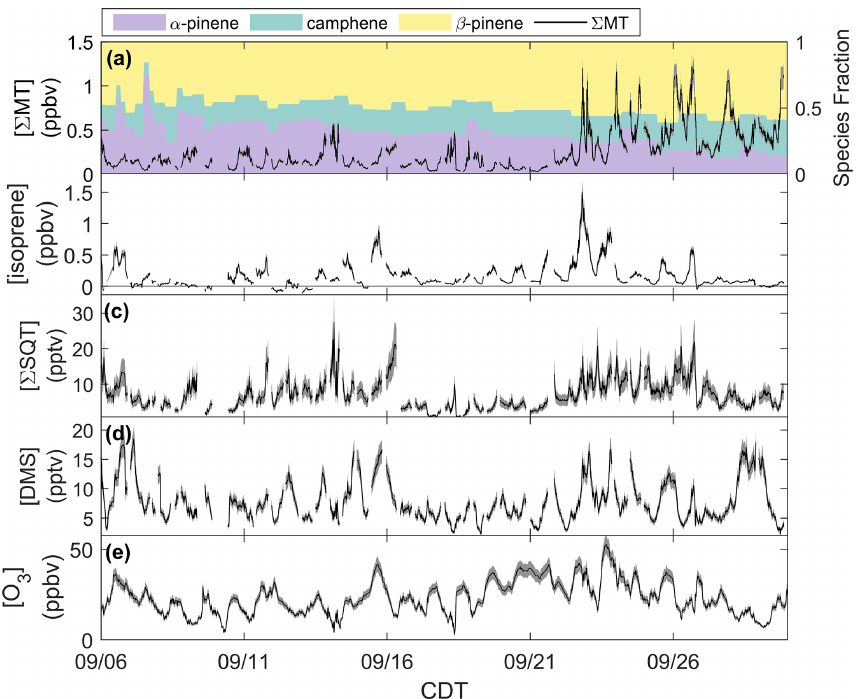
Figure 2. Mixing ratios of (a) (cid:54) MT, (b) isoprene, (c) (cid:54) SQT, (d) DMS, and (e) O 3 from 6–30 September 2020 with shaded uncertainties. Leaf senescence generally began around 16 September, and leaf abscission began around 21